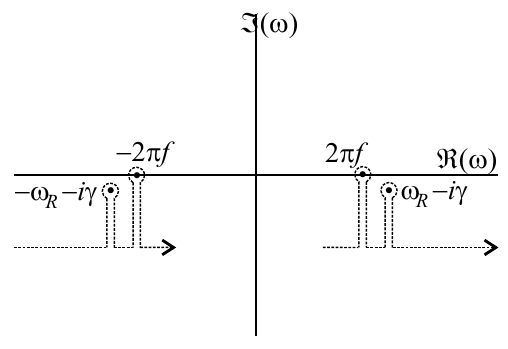
Fig. 10. Distortion of